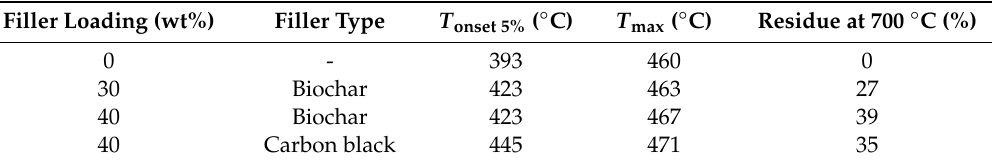
Figure 4. Thermal stability of different composites: neat polypropylene (PP), biochar (30 and 40 wt%), and carbon black (40 wt%).